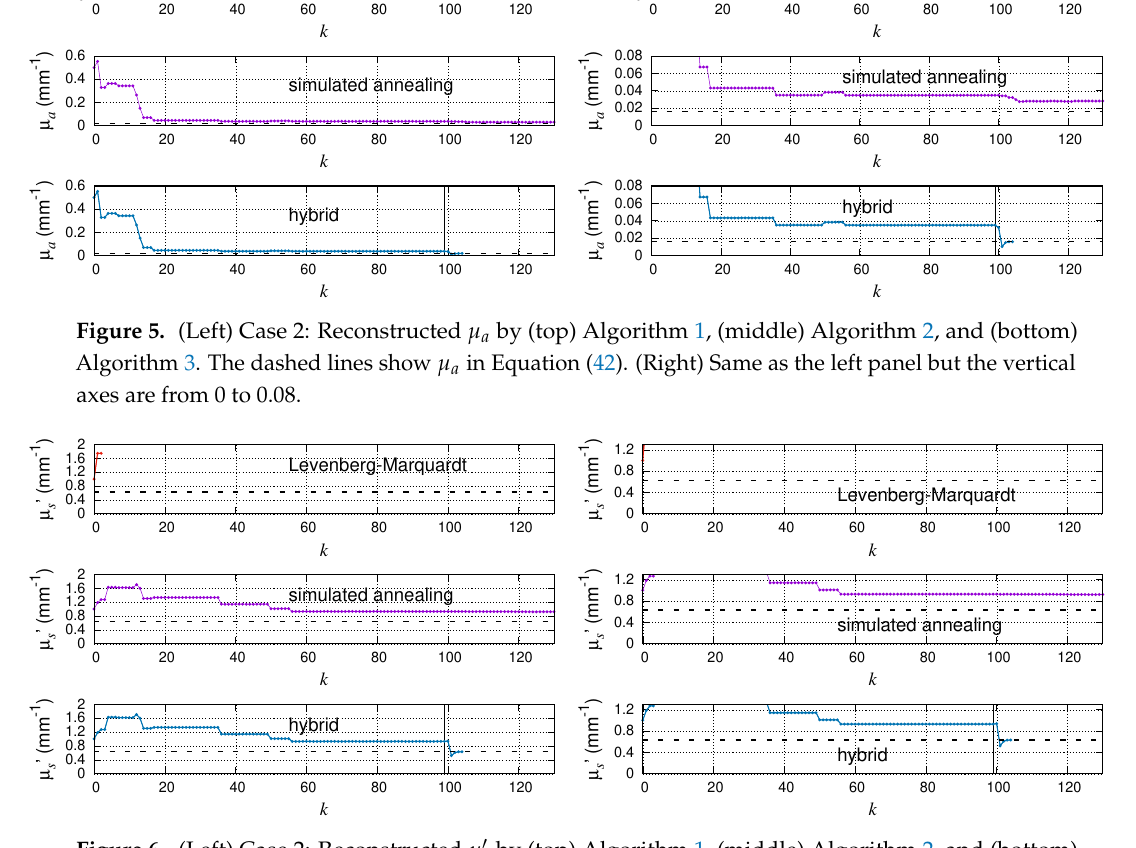
Figure 6. (Left) Case 2: Reconstructed µ (cid:48) s by (top) Algorithm 1, (middle) Algorithm 2, and (bottom) Algorithm 3. The dashed lines show µ (cid:48) s in Equation (42). (Right) Same as the left panel but the vertical axes are from 0 to